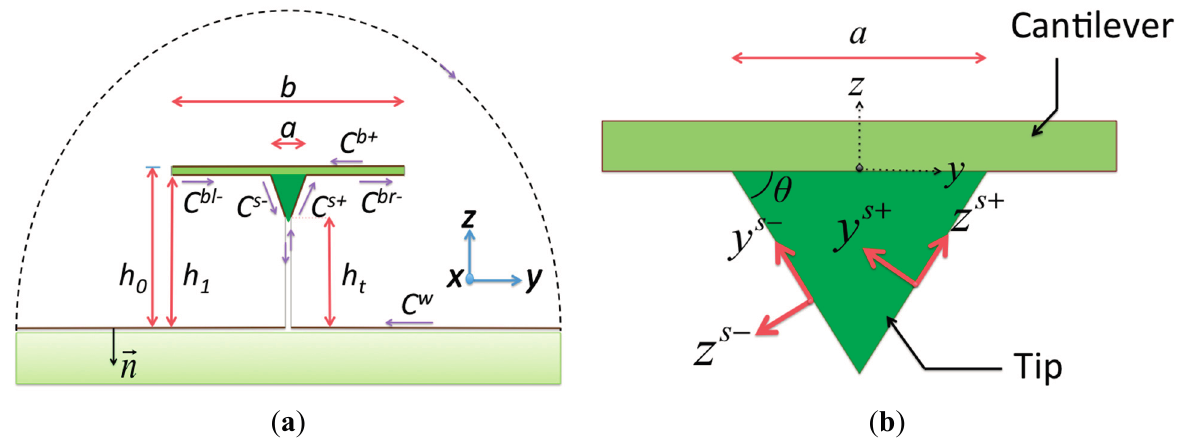
Figure 1. Cross sections of the system: ( a ) the integral path of the semi-analytical method and the global coordinate system and ( b ) the local coordinate system of the tip